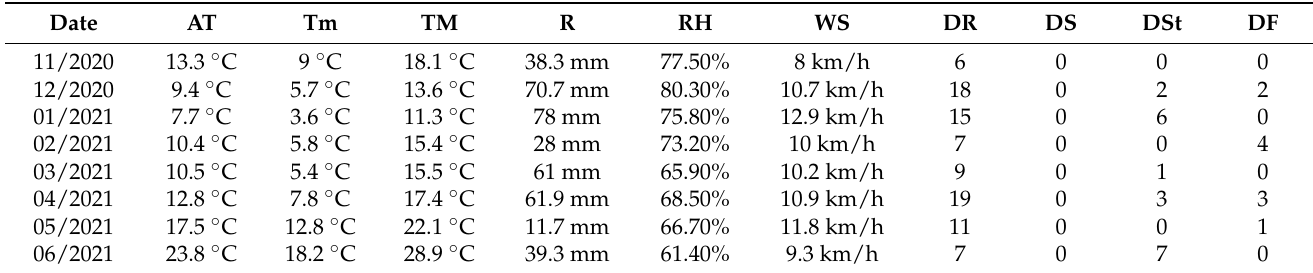
Table 2. Climate conditions during the period of the experimentation. AT = Average Temperature; Tm = minimum Temperature; TM = maximum Temperature; R = maximum Rainfall; RH = relative humidity; WS = Wind Speed; DR = Days of Rain; DS = Days of Snow; DSt = Days of Storm; DF = Days of Fog.